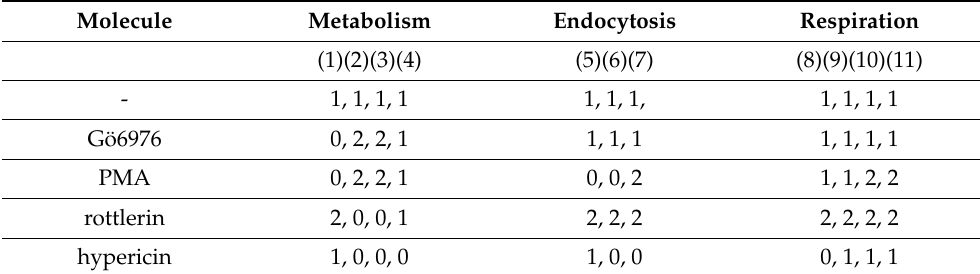
Table 1. Categorical values of parameters 1–11 (features, characteristics) related to metabolism, endocytosis, and respiration (see Section 2.5) of the cells. 1—base level (control cells), 0—stabilization (related to cell survival), 2—disintegration of the system. This table was compiled from the results of previously reported studies (see Ref. in Section 2.5).